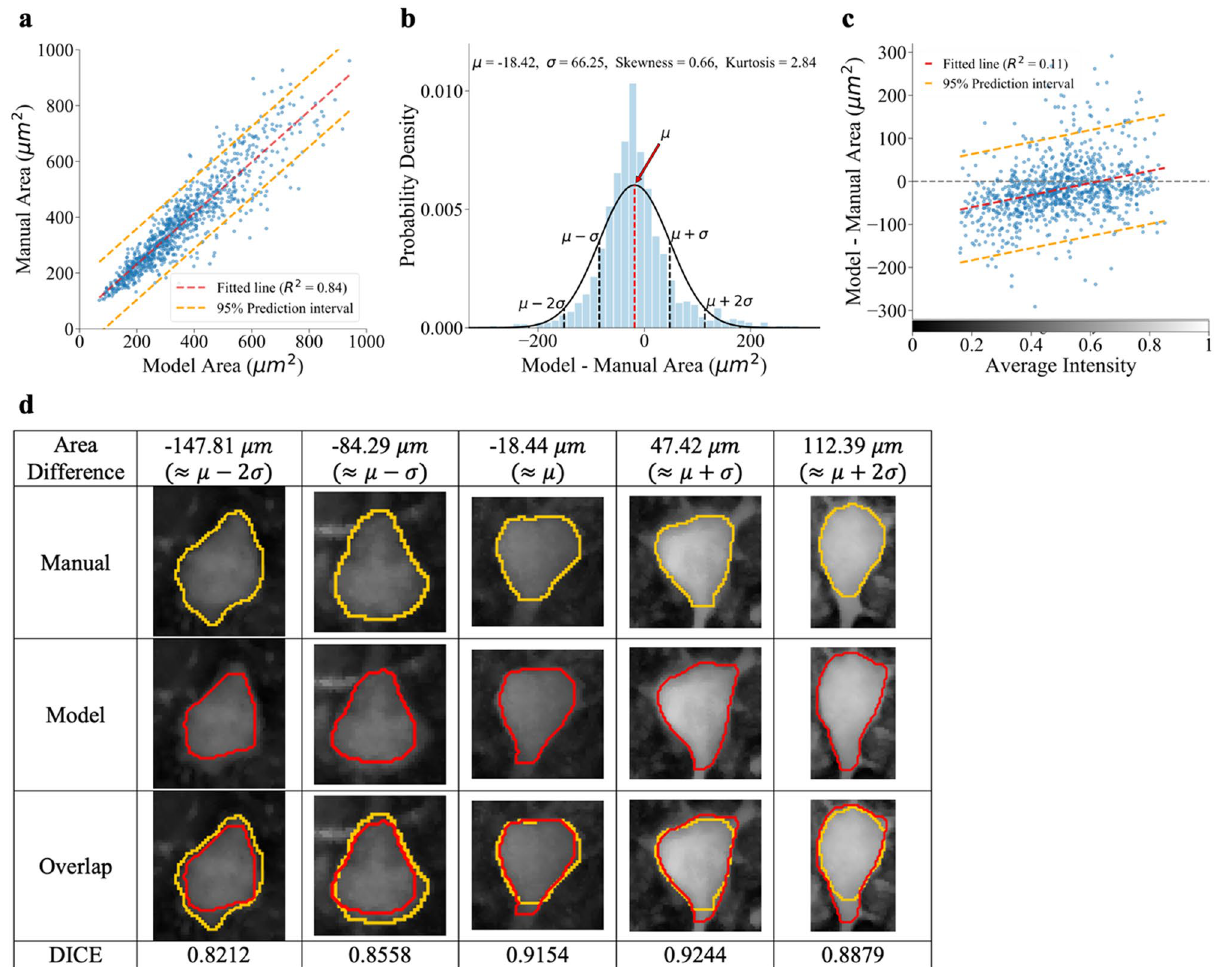
Figure 2. ANMAF performed similarly to manual annotators. ( a ) Correlation between manual area and model area. ( b ) Probability density of the differences between model and manual area. The black curve is the Gaussian fit. Blue bars represent the distribution of the actual data. ( c ) Neurons’ average intensity versus area difference with the standard least square regression and 95% prediction interval. ( d ) Examples of manual and model area